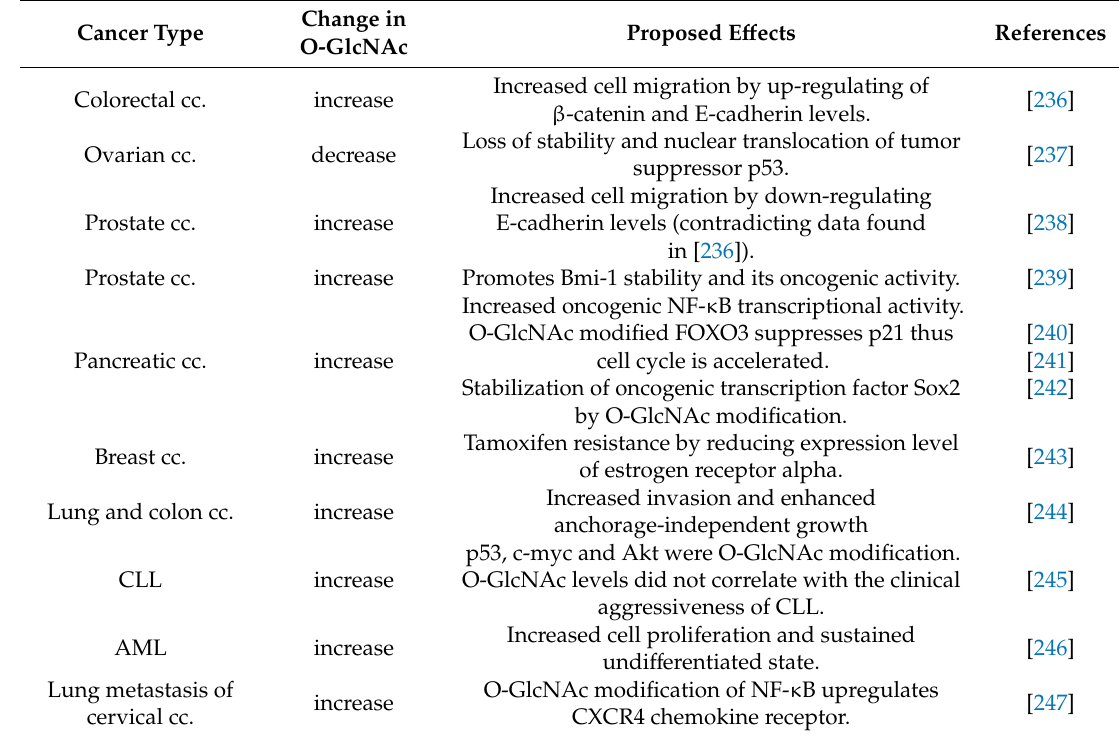
Table 1. Altered O-GlcNAc levels found in various types of